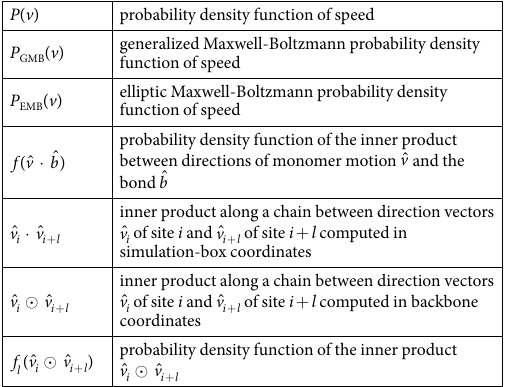
Table 3. Statistical